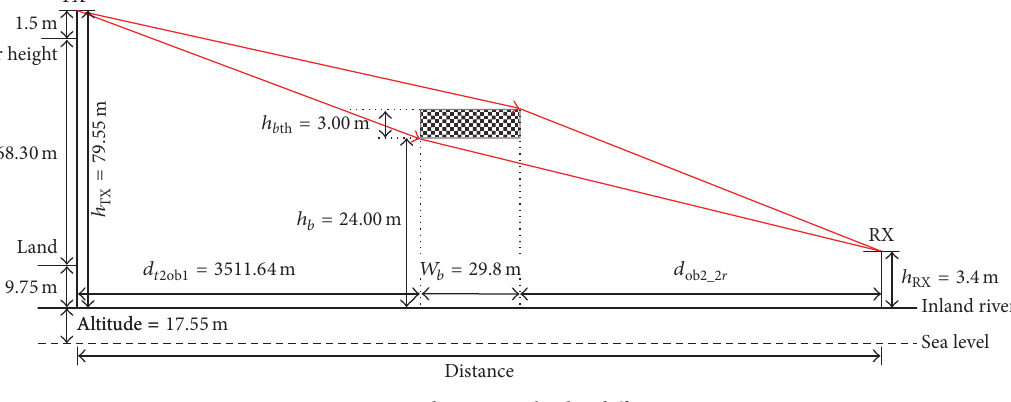
Figure 9: Finite dimensions bridge diffraction.